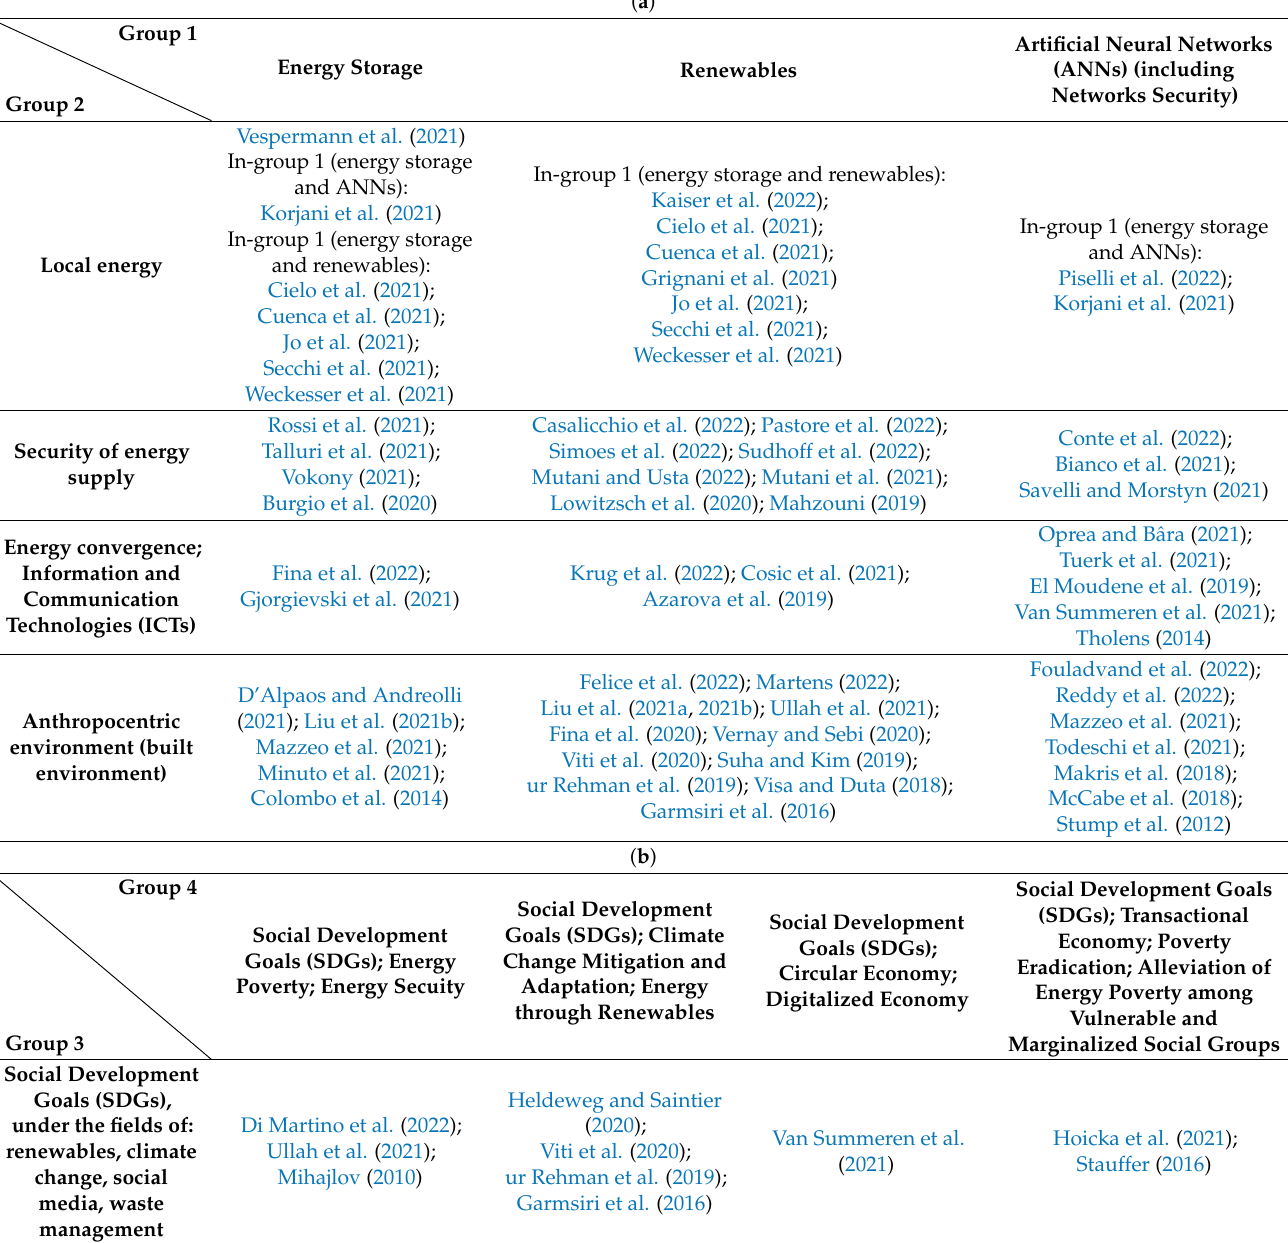
Table 2. In-groups’ allocation of literature dimensions into contexts of energy communities in two pairs: ( a ) Groups 1 and 2, ( b ) Groups 3 and 4 (studies are presented in reverse chronological order and in last name of first author alphabetical